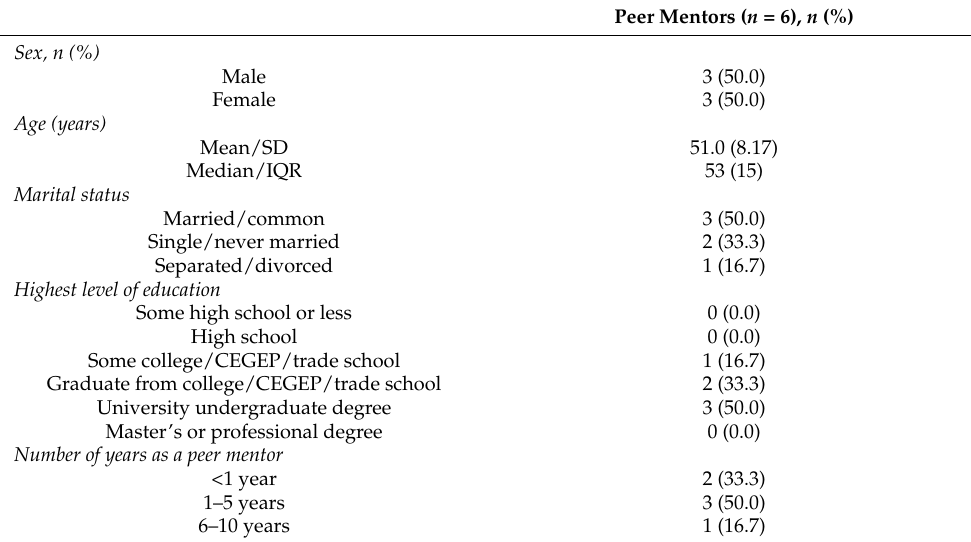
Table 2. Peer mentor demographic data at